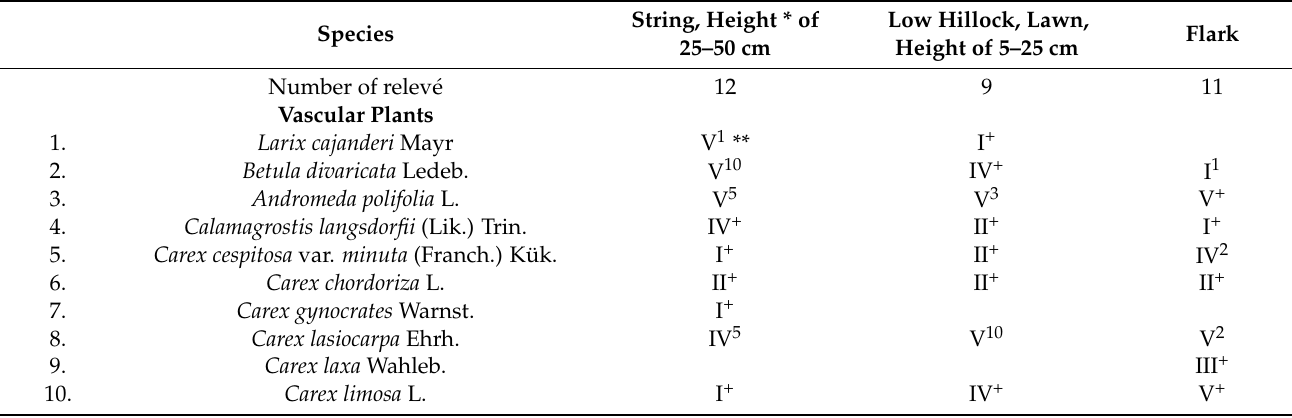
Table 1. Phytocoenotic record of aapa complex microforms.